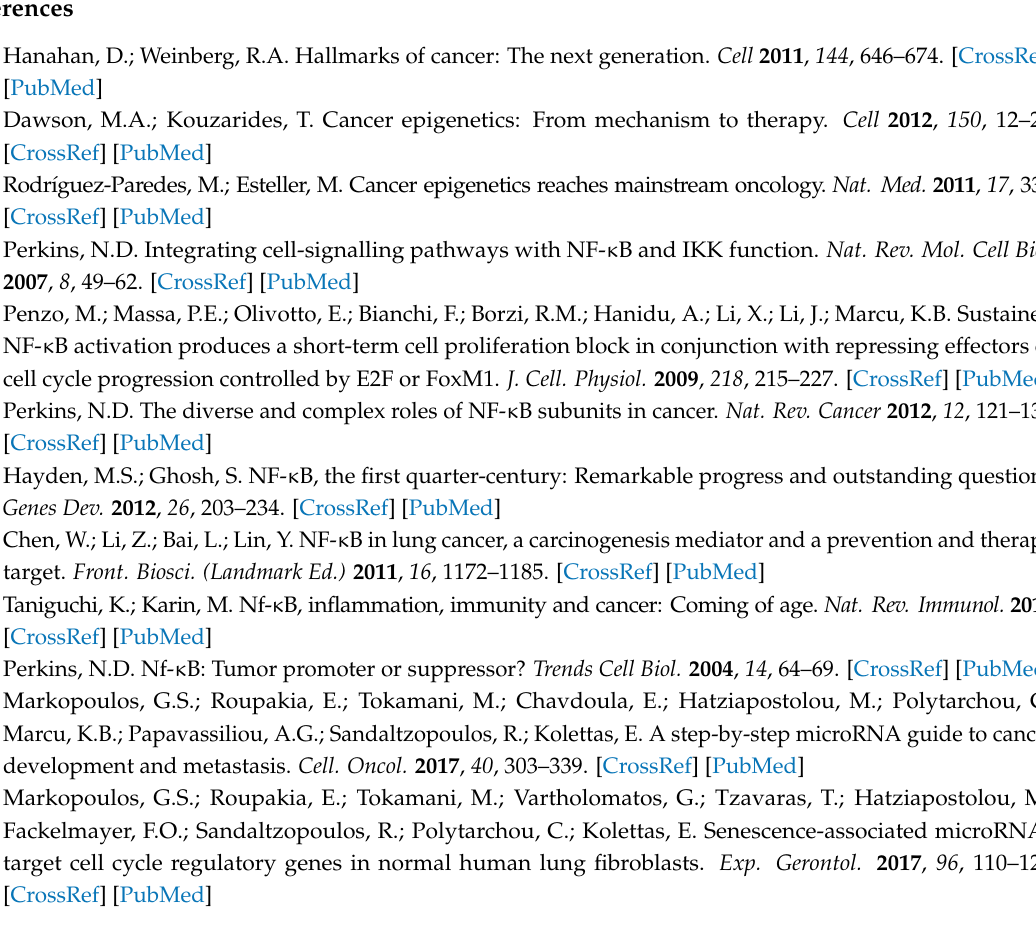
Table S1: Validated miRNAs for targeting at least one of NF- κ B signaling components. (# Denotes the number of NF- κ B genes